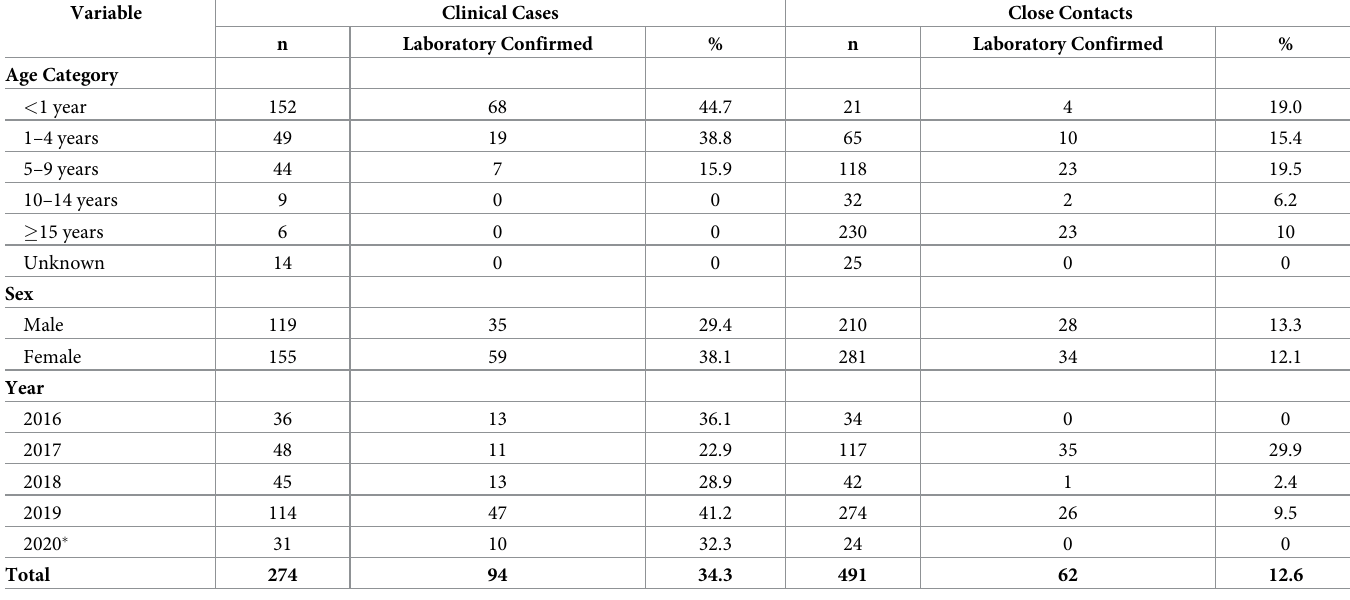
Table 2. Proportion of clinical and confirmed cases of pertussis and close contacts by age, sex, and year of sample